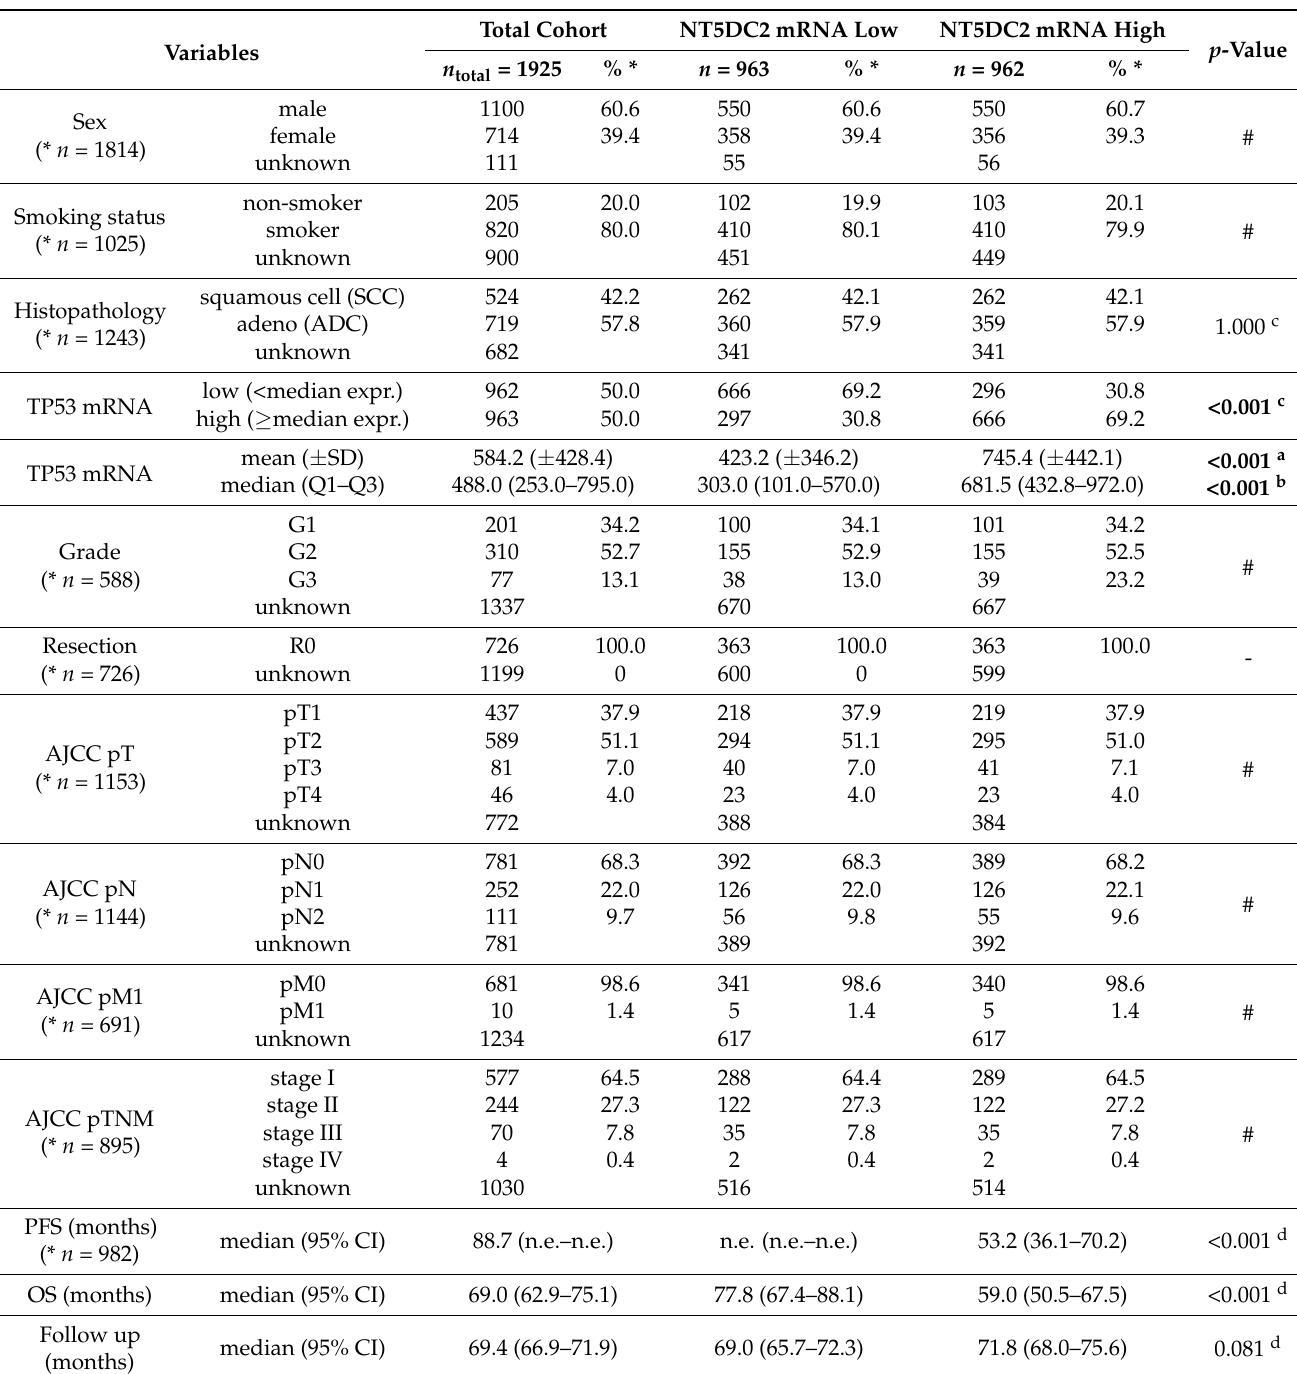
Table 2. Baseline characteristics of the gene expression analysis cohort.